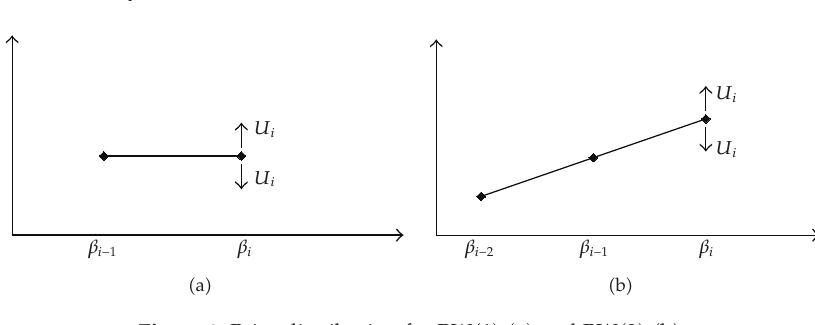
Figure 2: Prior distribution for RW (cid:3) 1 (cid:4) (cid:3) a (cid:4) and RW (cid:3) 2 (cid:4) (cid:3) b (cid:4)